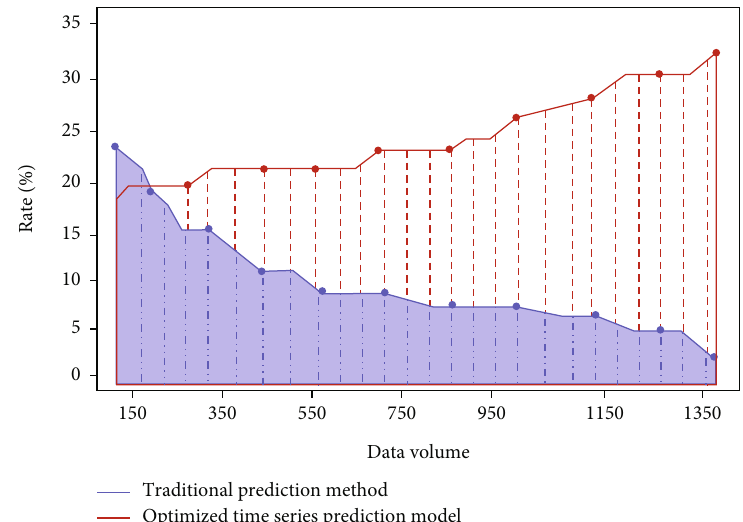
Figure 3: Comparison of processing speed between traditional prediction method and optimized time series prediction model.